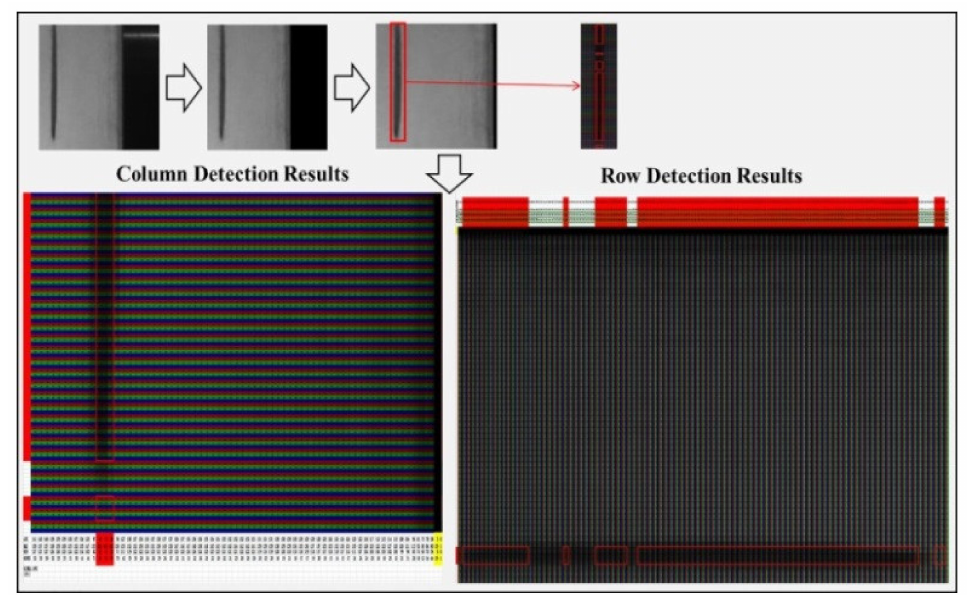
Figure 7. Detection results of a longitudinal flaw